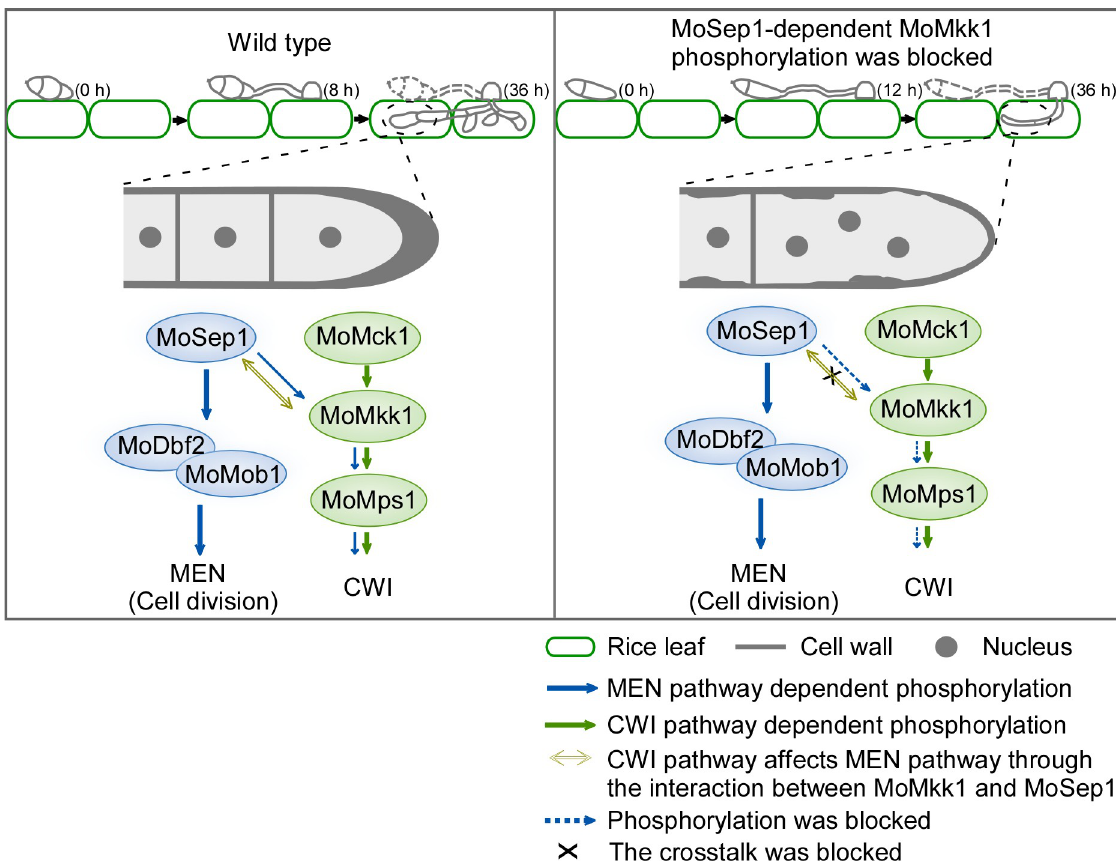
Fig 11. M . oryzae ensures cell wall integrity and normal progress of cell division through MoSep1-mediated MoMkk1 phosphorylation. Germination of conidia and expansion of infectious hyphae are accompanied by cell division and the cell wall synthesis. Normally, the MEN pathway cross talks with the CWI pathway through MoSep1 specific phosphorylation of MoMkk1, completing cell division and concurrently ensuring cell wall integrity during infection. However, the crosstalk between cell division and CWI cannot respond when the interaction of MoSep1 and MoMkk1 is blocked. Septa could not be normally formed, multiple nuclei per cell, and disordered distribution of cell wall chitin led to disrupted cell division and impaired CWI. The abnormality results in loss or attenuation of